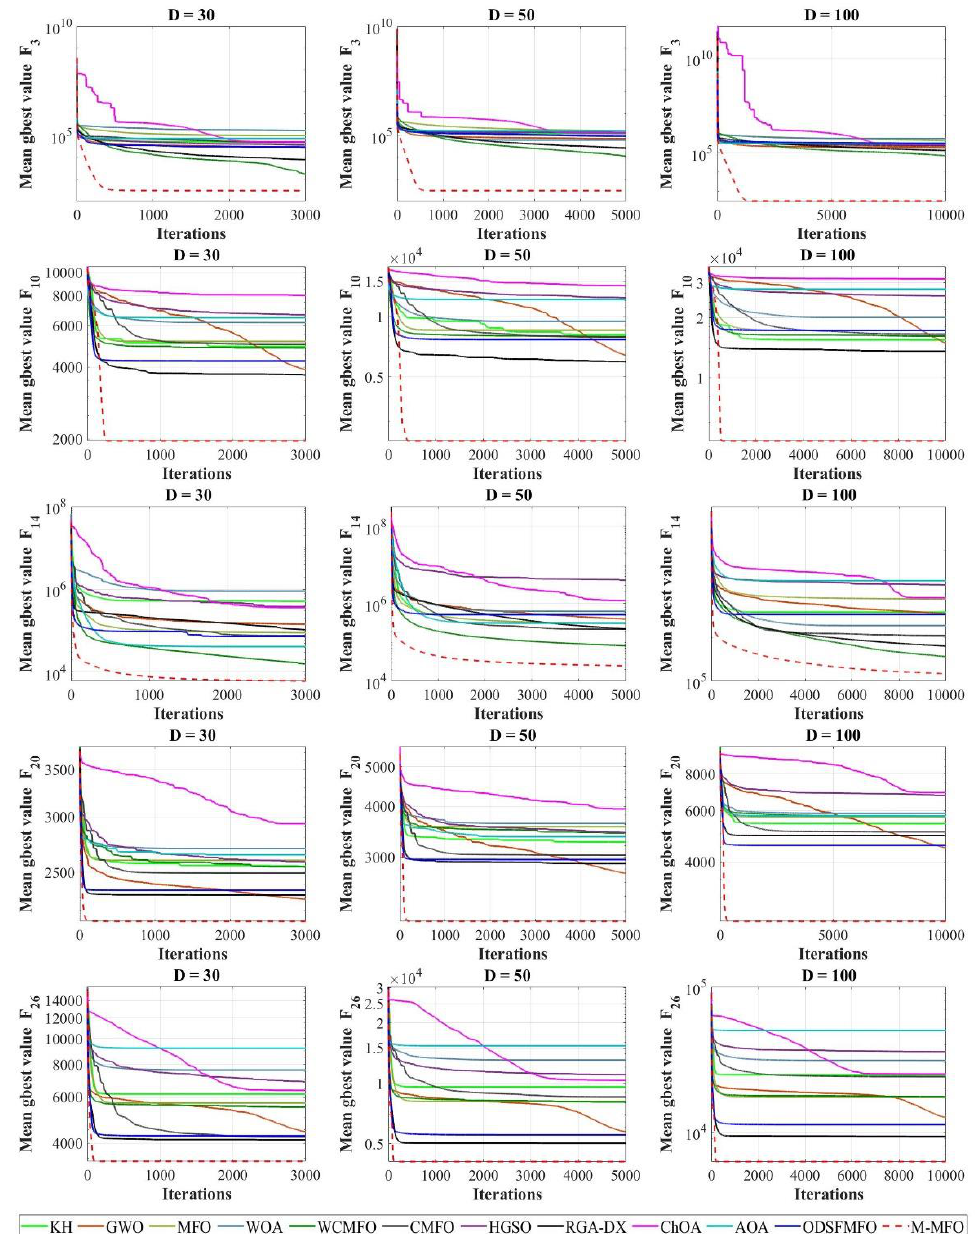
Figure 4. The convergence behavior of the proposed M-MFO and contender algorithms.